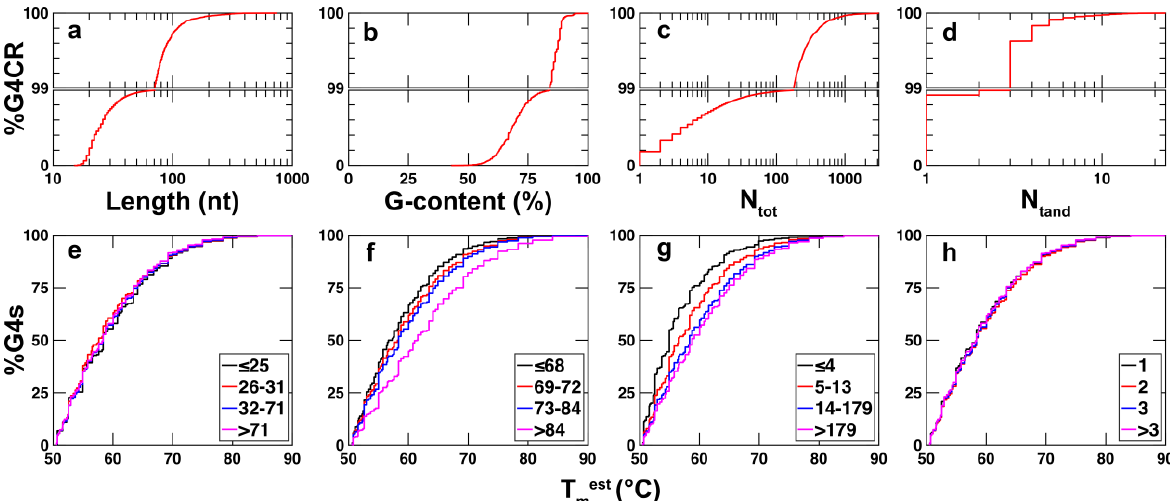
Figure 4. Cumulative plots of the ( a ) length, ( b ) G-content, ( c ) N tot , ( d ) N tand of G4CRs found in the human promoters. Cumulative plots of the estimated melting temperatures for G4s derived from G4CRs binned by ( e ) length, ( f ) percentage of residues that are G (G-content), ( g ) total number of G4 isomers (N tot ), ( h ) maximum number of simultaneous tandem G4s (N tand ).